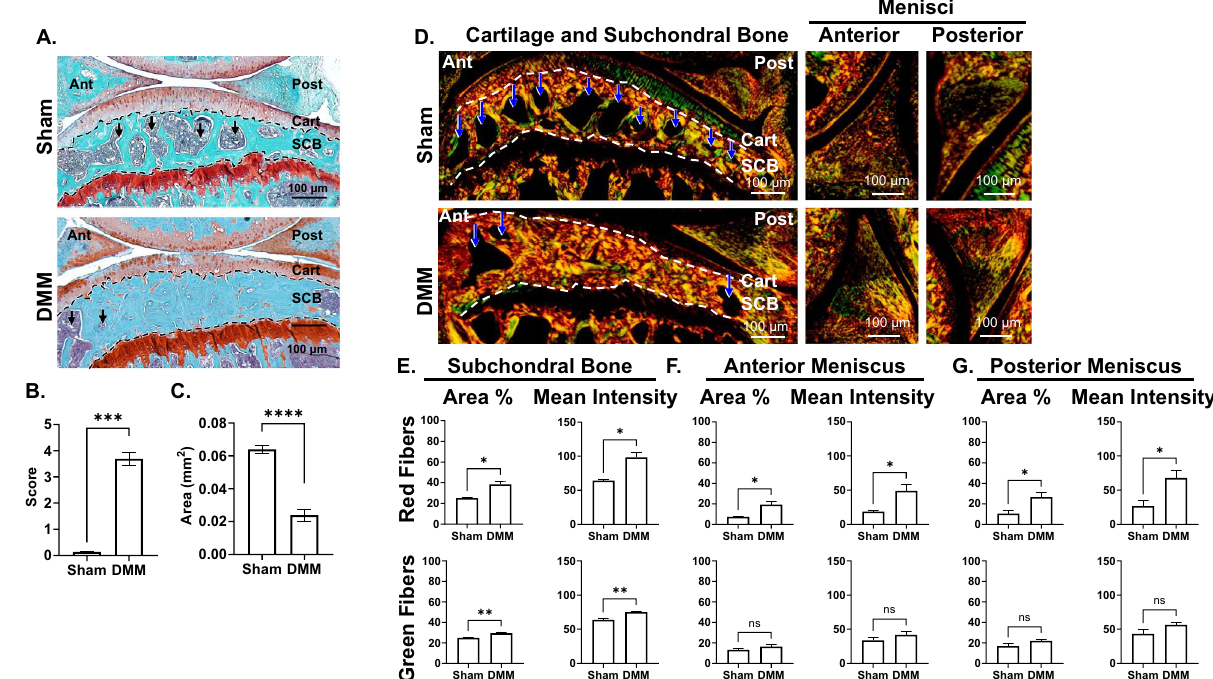
Figure 1. Picrosirius red staining of the knee joint shows changes in the microarchitecture of knee joint tissues in OA mice. ( A ) Representative Safranin-O/Fast Green staining for comparison of Sham and DMM knee joints (× 10 magnification, scale bar = 100 μm, images acquired with OsteoMeasure software) Ant = anterior, Post = posterior, Cart = cartilage, SCB = subchondral bone. Black arrows indicate marrow space in the SCB. ( B ) Osteoarthritis cartilage histopathology assessment system (OARSI) scoring for samples analyzed (0 = no OA activity seen, stage 0, 5 = > 50% involvement OA, stage 4). ( C ) Uncalcified tibial cartilage area (UTC) in mm 2 calculated by subtracting calcified cartilage area (cartilage between chondro-osseous junction and tideline) from total cartilage area (total articular cartilage above the chondro-osseous junction). ( D ) Representative images of PSR for a comparison of the collagenous structure in cartilage, subchondral bone, and anterior/posterior menisci. Thicker fibers typically stain red while thinner fibers stain green. Blue arrows indicate marrow space in the SCB (× 10 magnification, scale bar = 100 μm). PSR staining quantification of the area percentage and mean intensity of red and green fibers in the ( E ) subchondral bone, ( F ) anterior meniscus, and ( G )